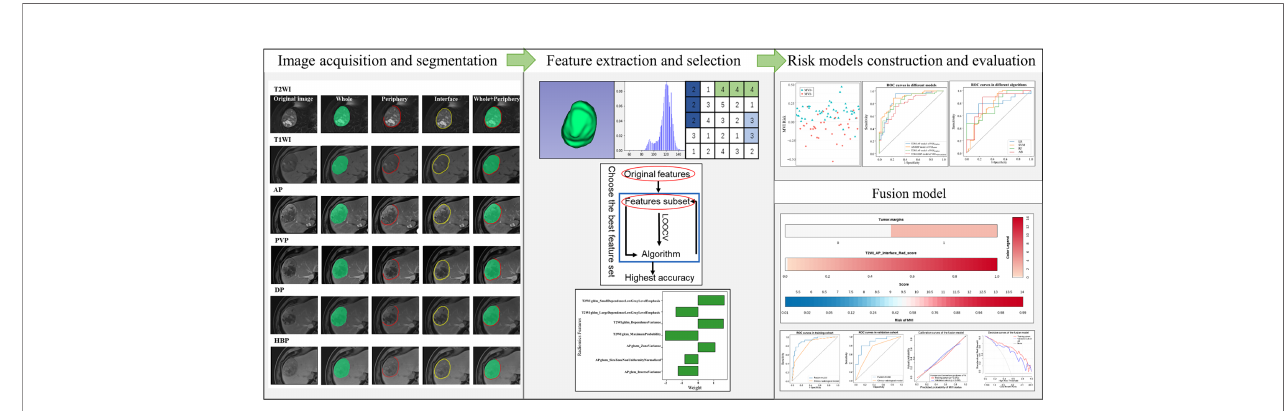
FIGURE 2 | Work fl ow of radiomics analysis.